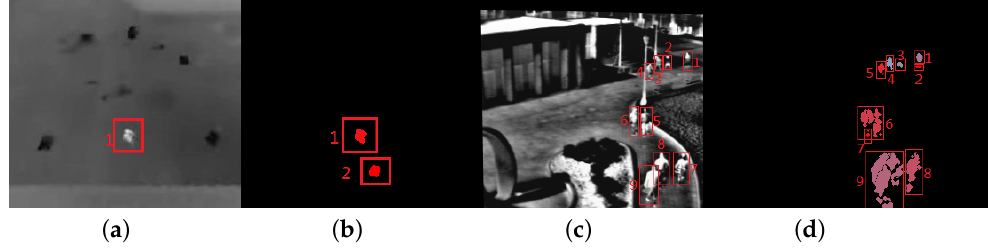
Figure 10. The two typical results of the proposed method. ( a ) The 20th frame in Seq. 1; ( b ) the proposed method estimates of ( a ); ( c ) the 486th frame in Seq. 4; ( b ) the proposed method estimates of ( c ).